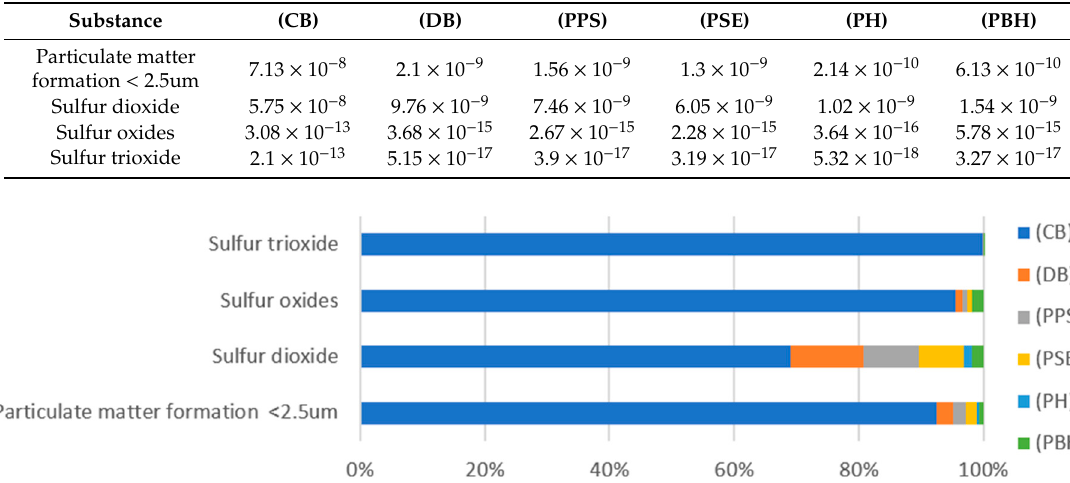
Table 6. Results of characterization of environmental impacts on category of particulate matter formation (DALY).